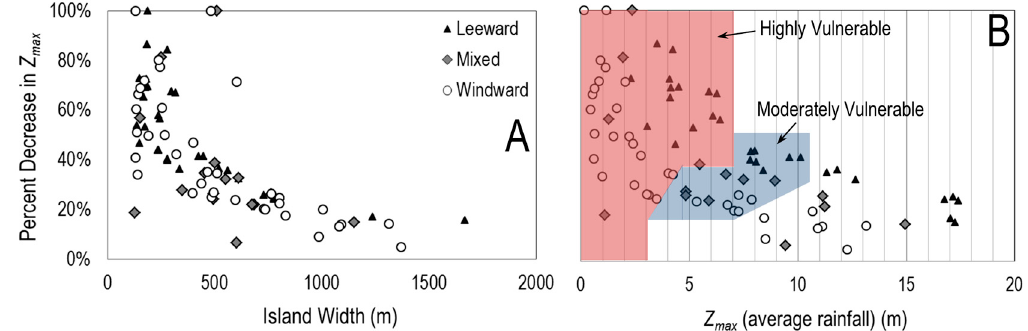
Figure 10. Percent decrease of Z max during a major drought, plotted against ( A ) island width and ( B ) Z max during average rainfall conditions. ( B ) shows the set of islands that are “Highly” and “Moderately” vulnerable to drought, based on a criterion of Z max ≥ 3 m during the peak of the drought.